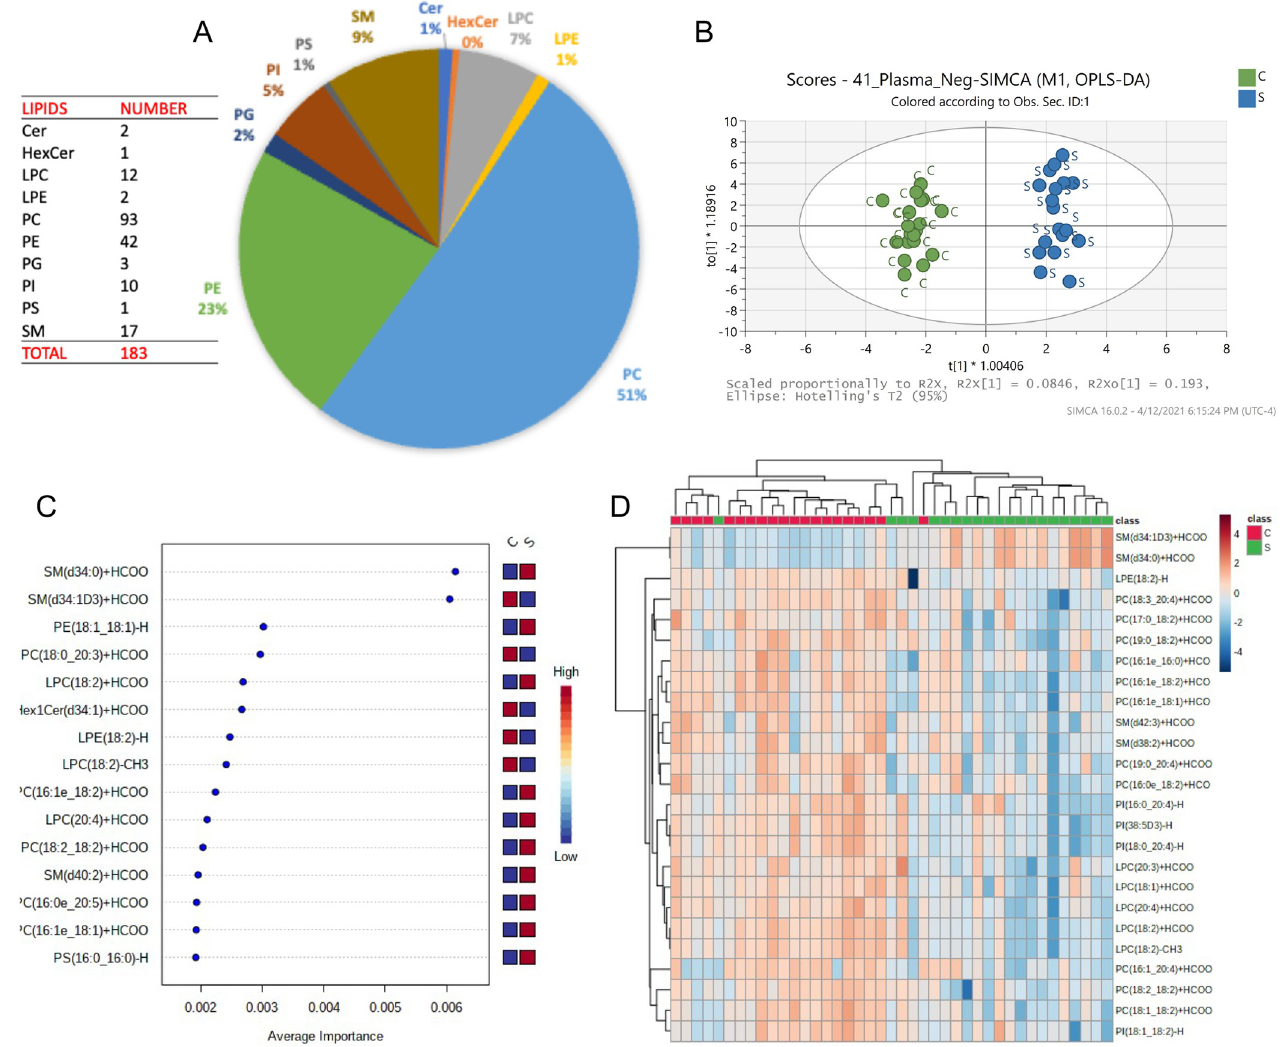
Fig 9. Lipids identified in negative mode 183 lipids (inc. isomers after filtering data). Highest amount corresponded to PC. C30 negative mode: OPLS-DA plot and Heatmap. Multivariate and significant features detection analysis. Compounds detected in C30 negative mode ranked by average